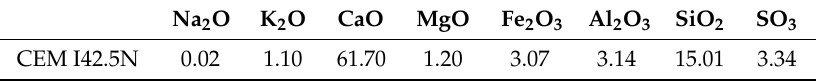
Table 1. Elemental analysis of cement, expressed in oxides.